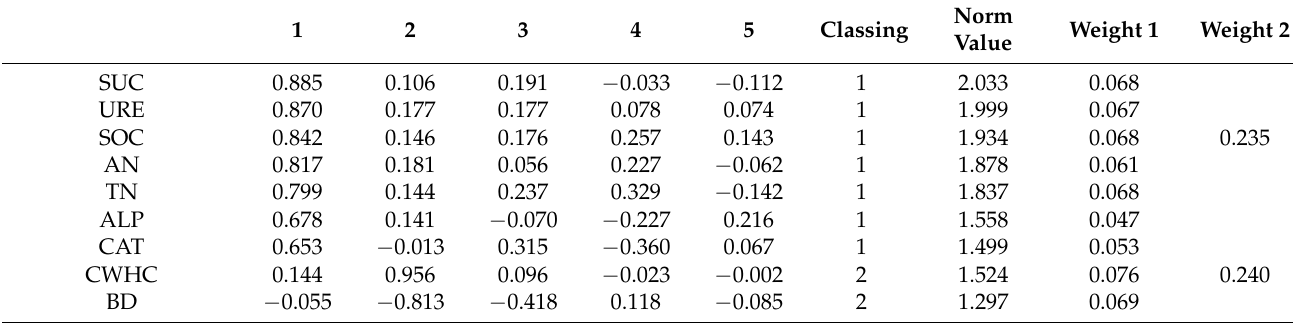
Table 4. The soil quality evaluation results.